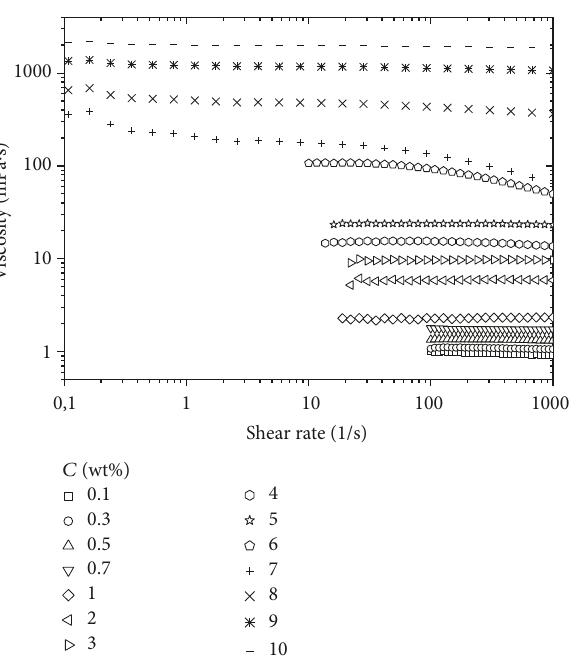
Figure 8: Variation of the viscosity as a function the shear rate for various concentrations of PAM.